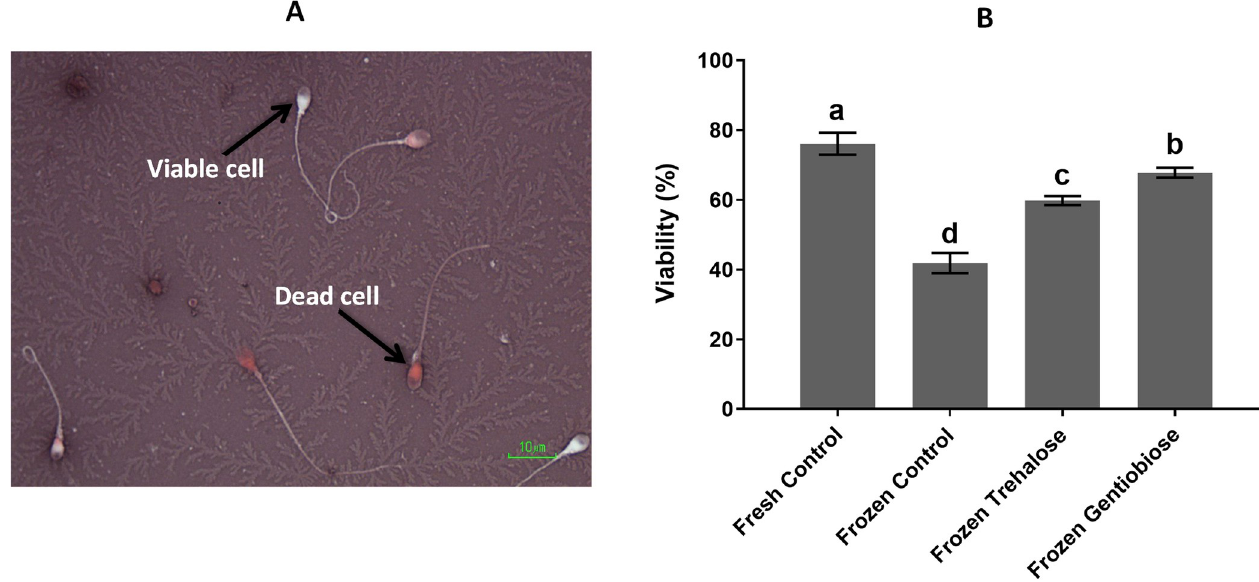
Fig 2. The viability of sperm. The viable and dead cells are observed in panel A. The Eosin-Nigrosin staining was used, where colorless sperm and complete/ partial stained sperm show live and dead sperm, respectively (A). The percentage of viable cells differed in all experimental groups (B). The assigned letters a, b, c, and d indicate significant differences (P < 0.05). Values are expressed as mean ± SD, Tukey test; n =